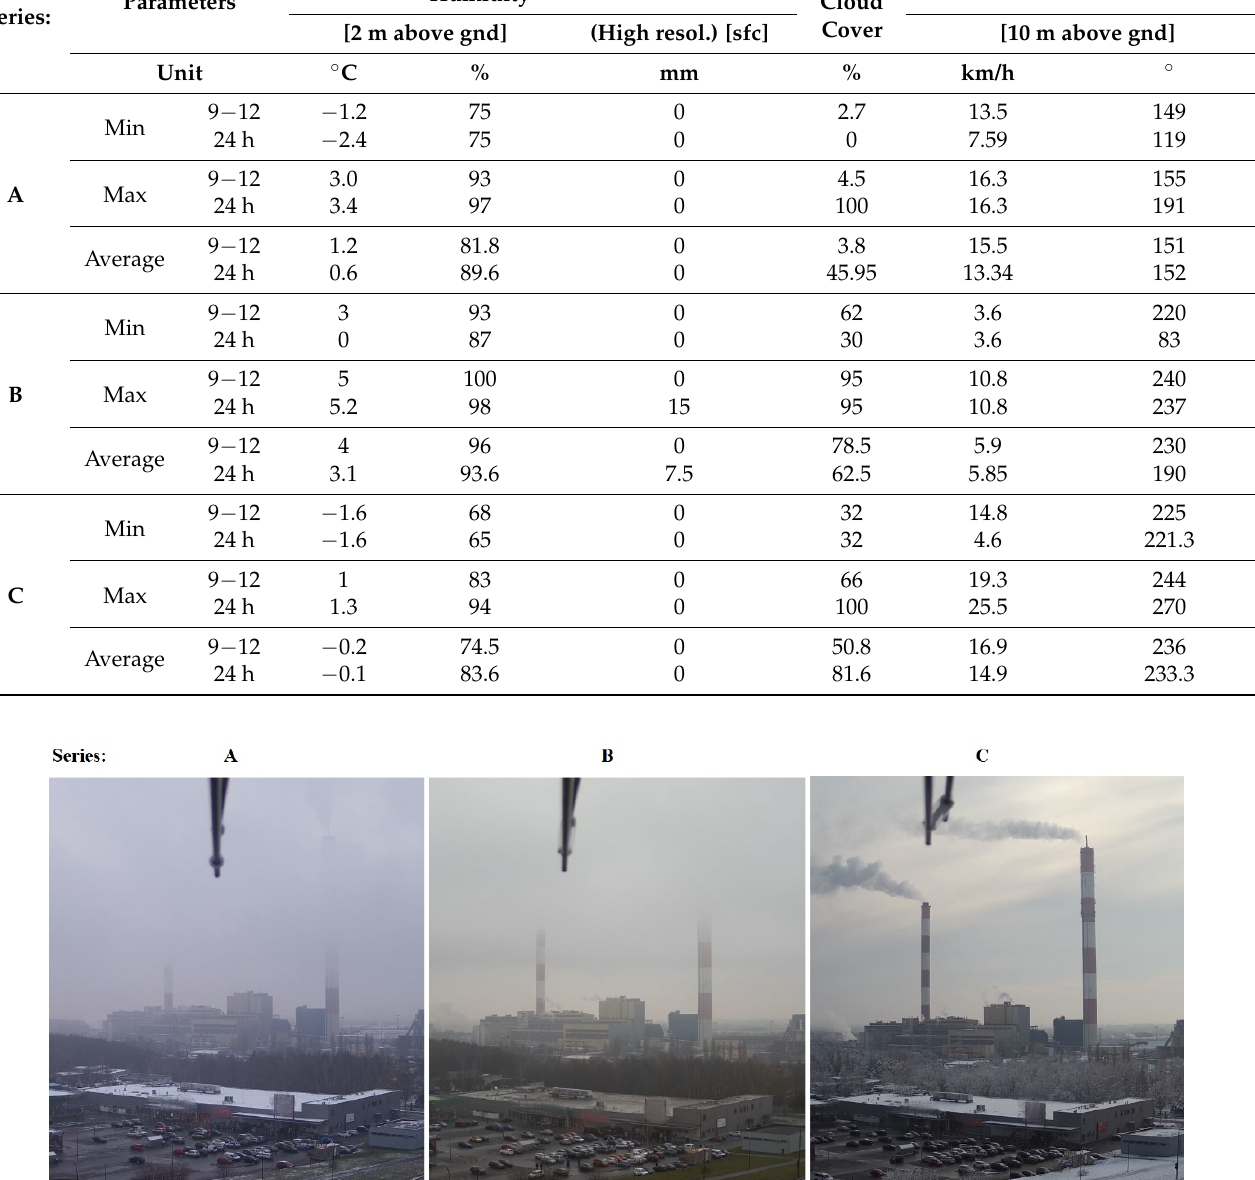
Table 1. Statement of meteorological parameters (data source : www.meteoblue.com).